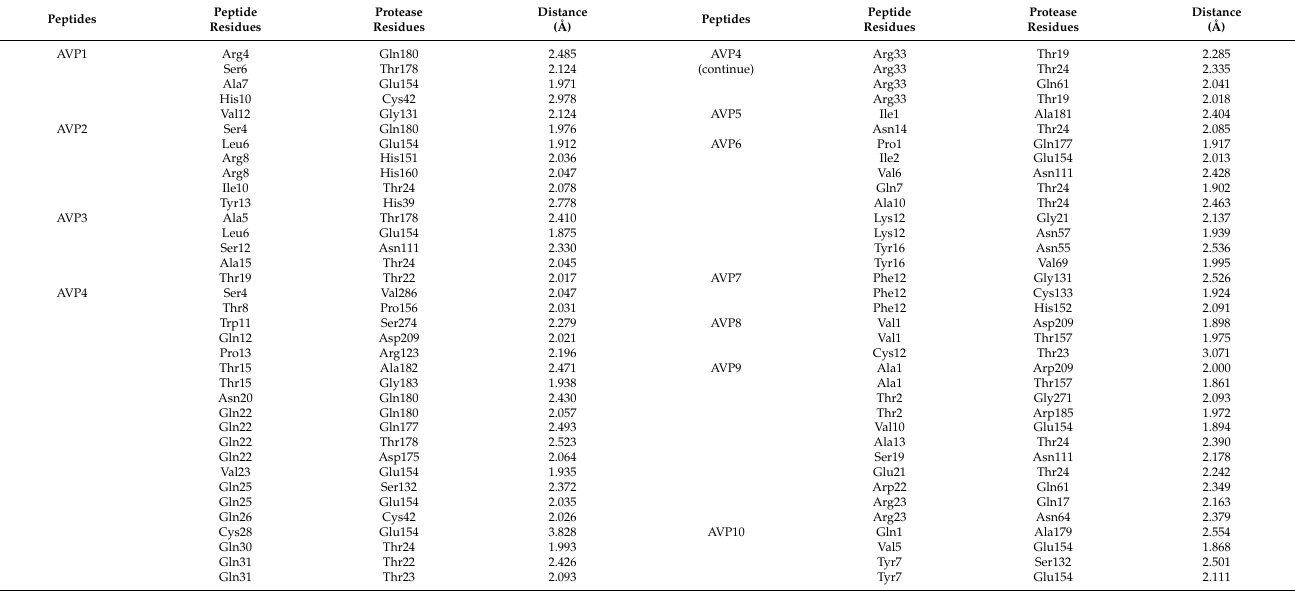
Figure 4. Comparative molecular docking of the ten top-ranked AVPs (AVP1 to AVP10) on the crystal structure of the SARS-CoV-2 main protease in the apo state (PDB ID: 7C2Q) shown with ( A ) and without ( B ) the enzyme structure. The structure of the SARS-CoV-2 main protease is shaded in gold, and the peptides are labeled with different colors. Table 3. List of hydrogen bonds observed from the molecular docking of ten peptides (AVP1 to AVP10) to the crystal structure of the SARS-CoV-2 main protease in the apo state (PDB ID: